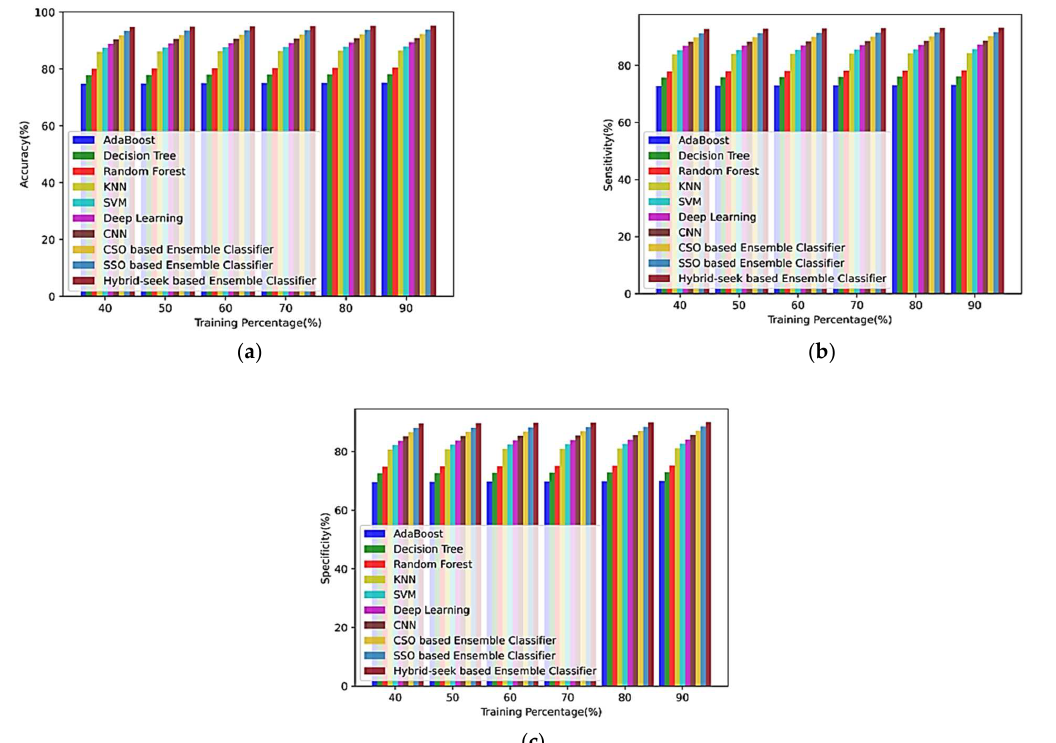
Figure 10. Comparison of the training % of the Siena Scalp database with other classifiers for ( a ) accuracy, ( b ) sensitivity, and ( c )